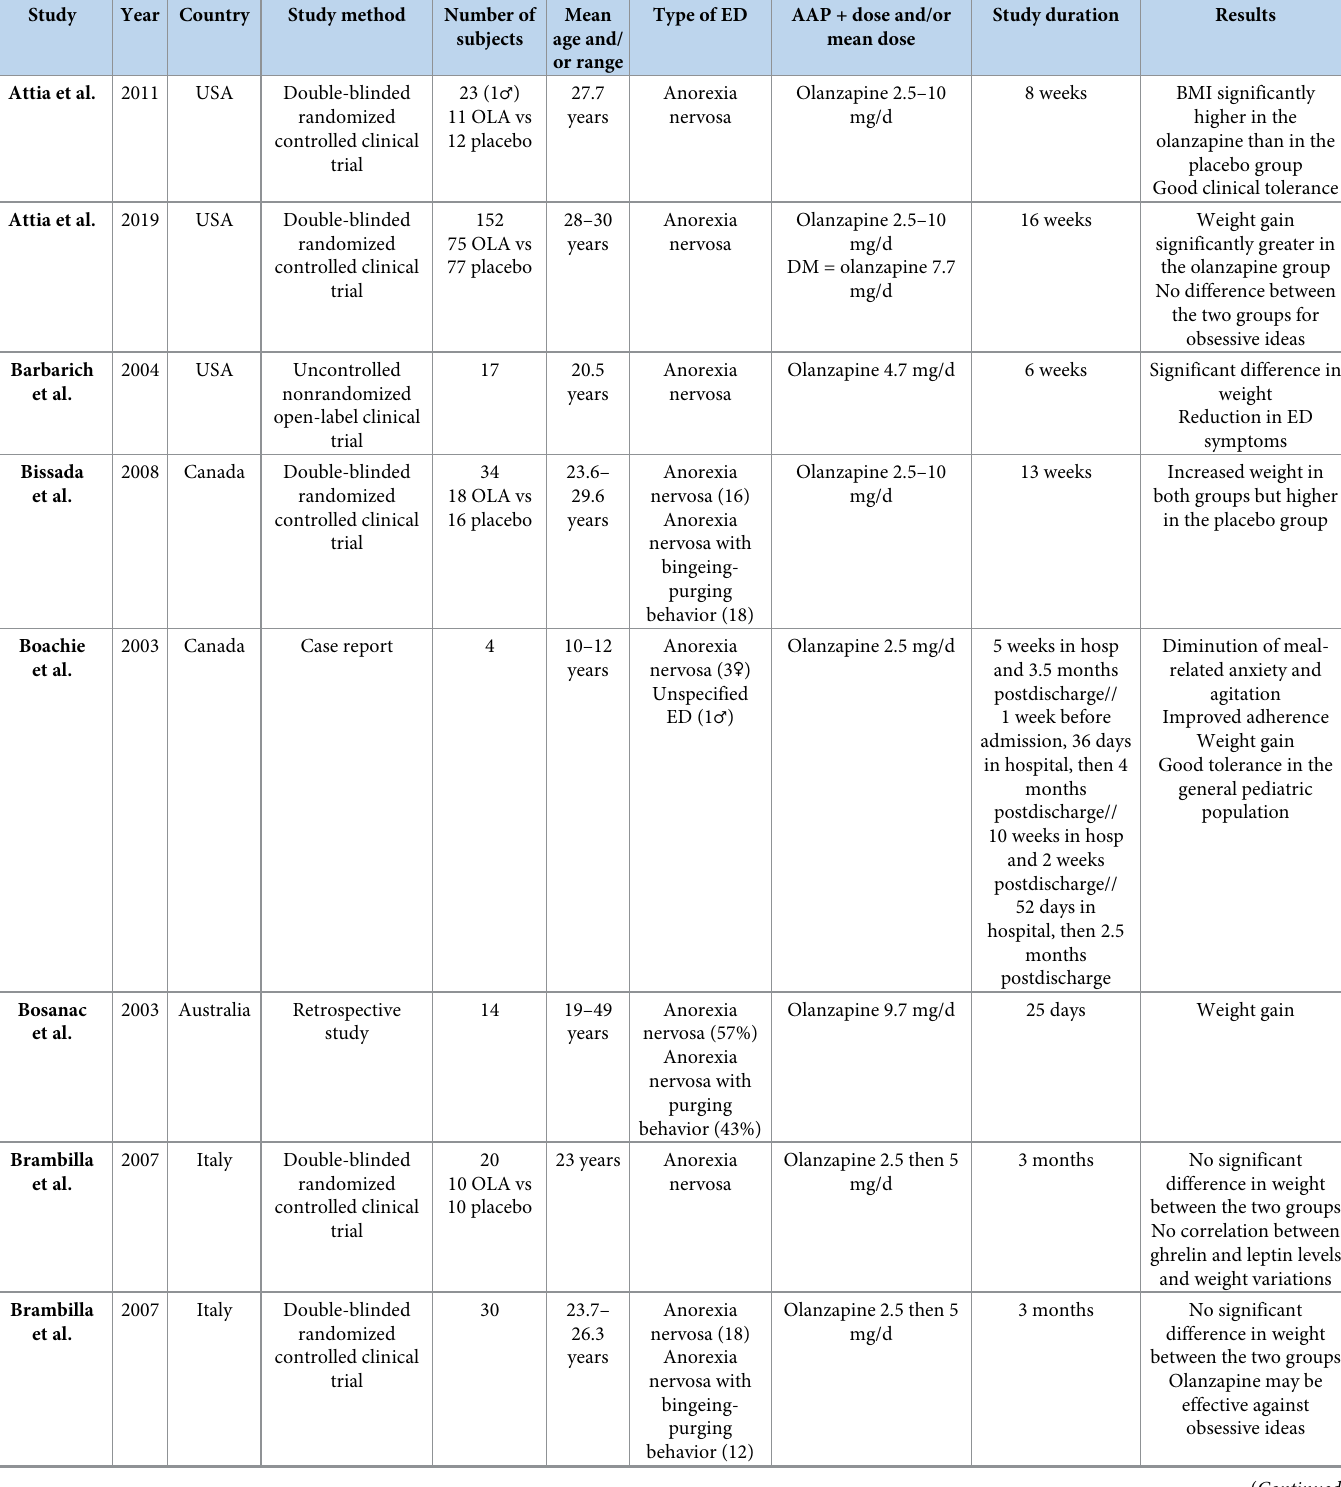
Table 1. Articles about olanzapine included in the scoping